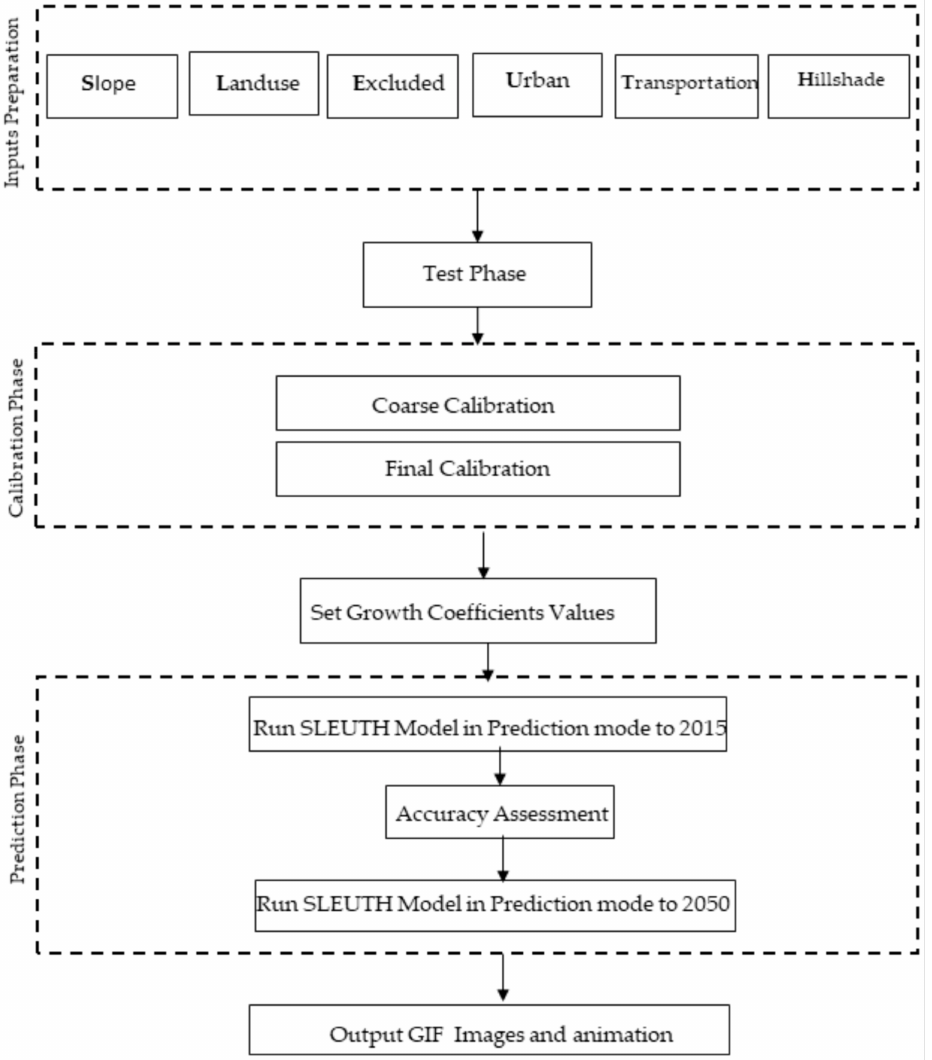
Figure 3. The flowchart of SLEUTH